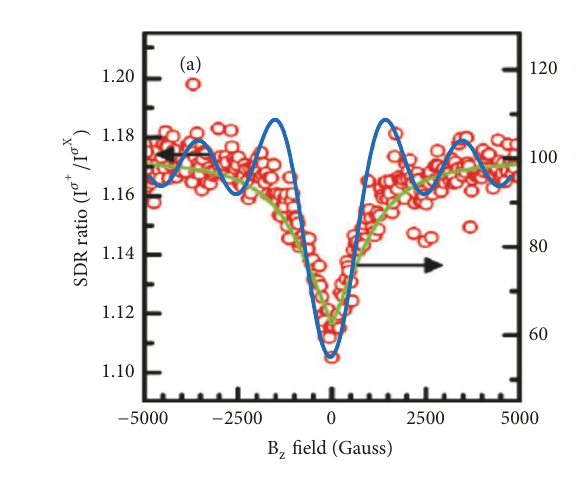
Figure 2: Experimental results of the field effect on the spin- dependent recombination ratio reported in Ref. [5] and, on top of these data, we plot (blue curve) the spin polarization behavior as function of the magnetic field. The blue curve is for 𝜌 𝜐 (𝜀) = 10 8 𝜖 𝑠 , with 𝑠 = 2.5 , frequency 𝜔 𝑜 = 2.279 × 10 10 𝐵 s −1 , and 𝑡 = 1.410 −9 s. Reprinted figure with permission from [5]. Copyright (2013) by the American Physical